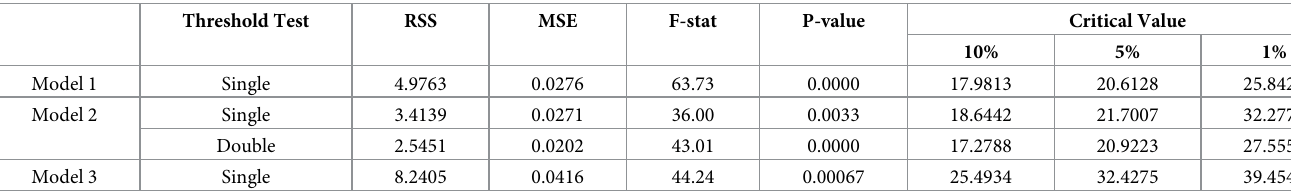
Table 13. Threshold effect existence test when LEI is threshold